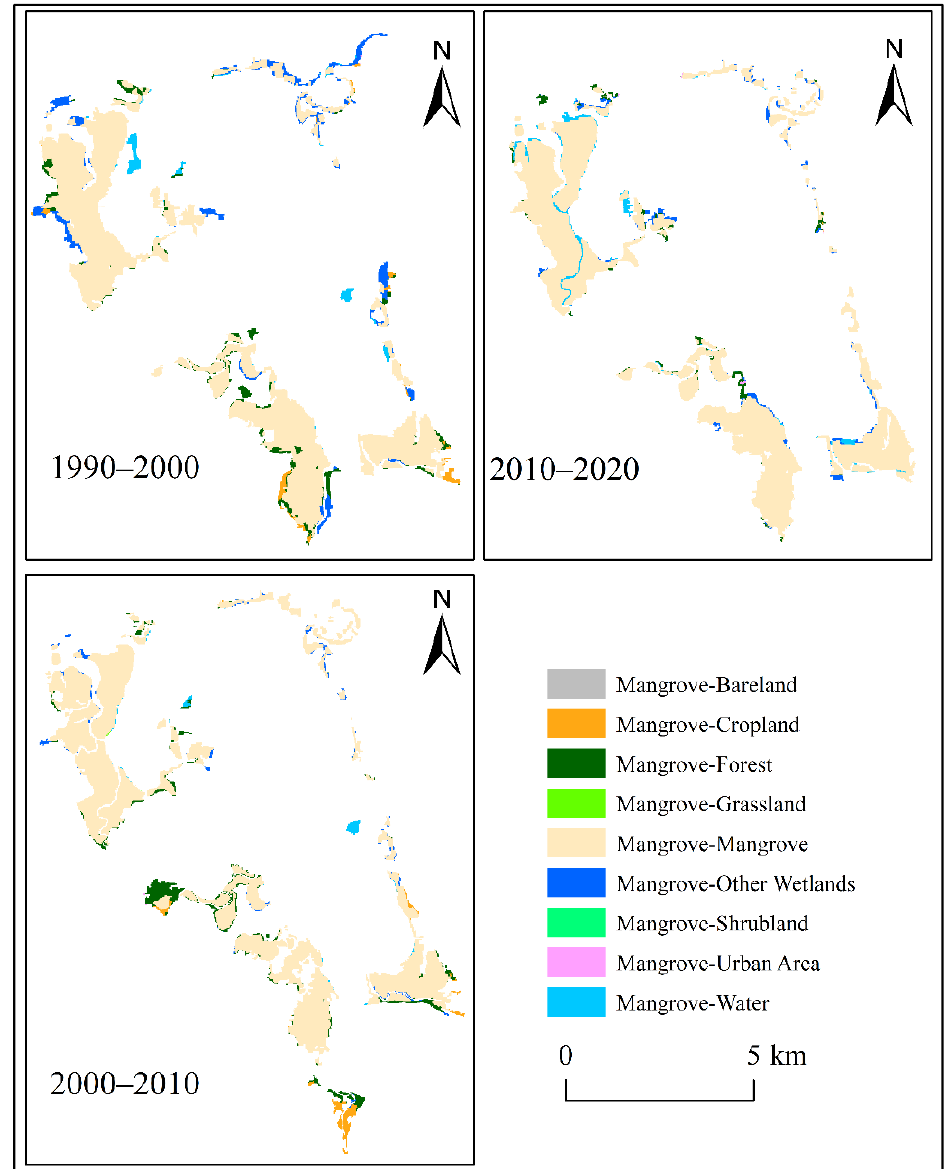
Figure 6. Maps of spatial–temporal distribution of mangrove degradation in Dongzhaigang from 1990 to 2020.